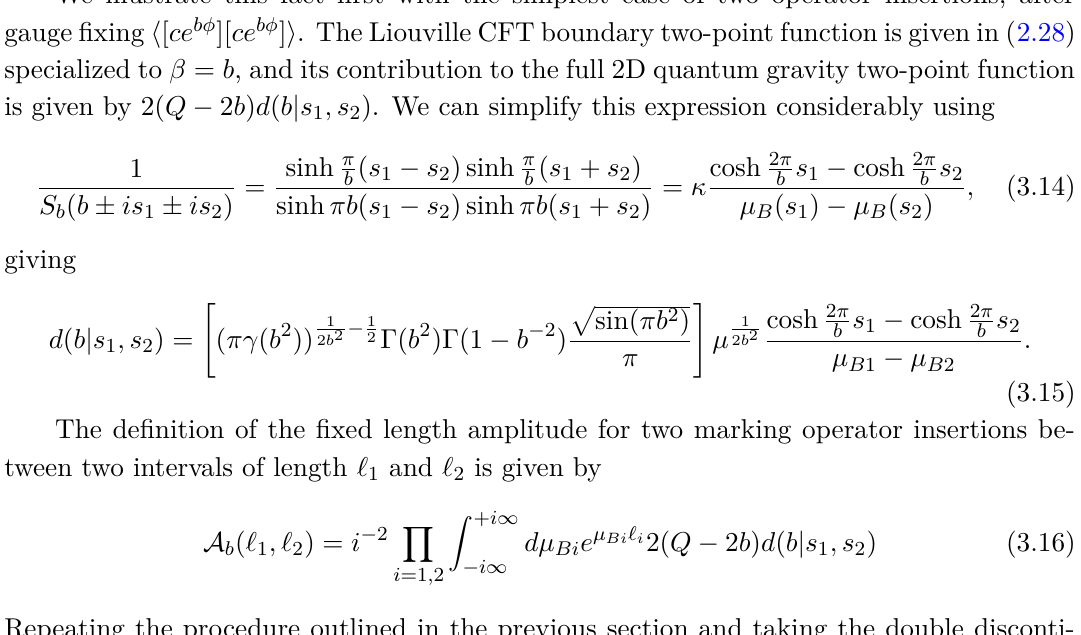
Figure 3 . FZZT brane segments between n marking operators leads upon transforming to the fixed length basis with length ‘ ≡ P ‘ j . In the figure we show an example with n = 3 . j dressed identity operator in the matter sector 1 . The resulting equality we mention here M is then indeed